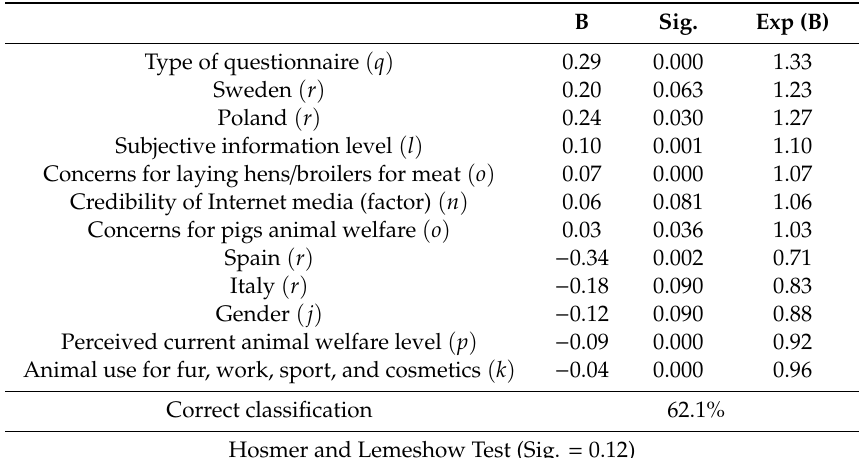
Table 5. Logit model to analyze factor a ff ecting the agreement with more restrictive